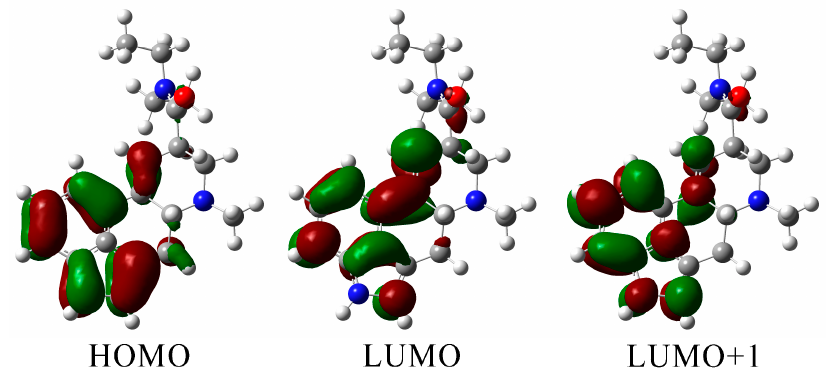
Figure 3. Electron density distribution of HOMO, LUMO, and LUMO+1 orbitals of the optimized structures of LSD (at M05-2X/6-311++G(d,p) level of theory, isovalue = 0.02).